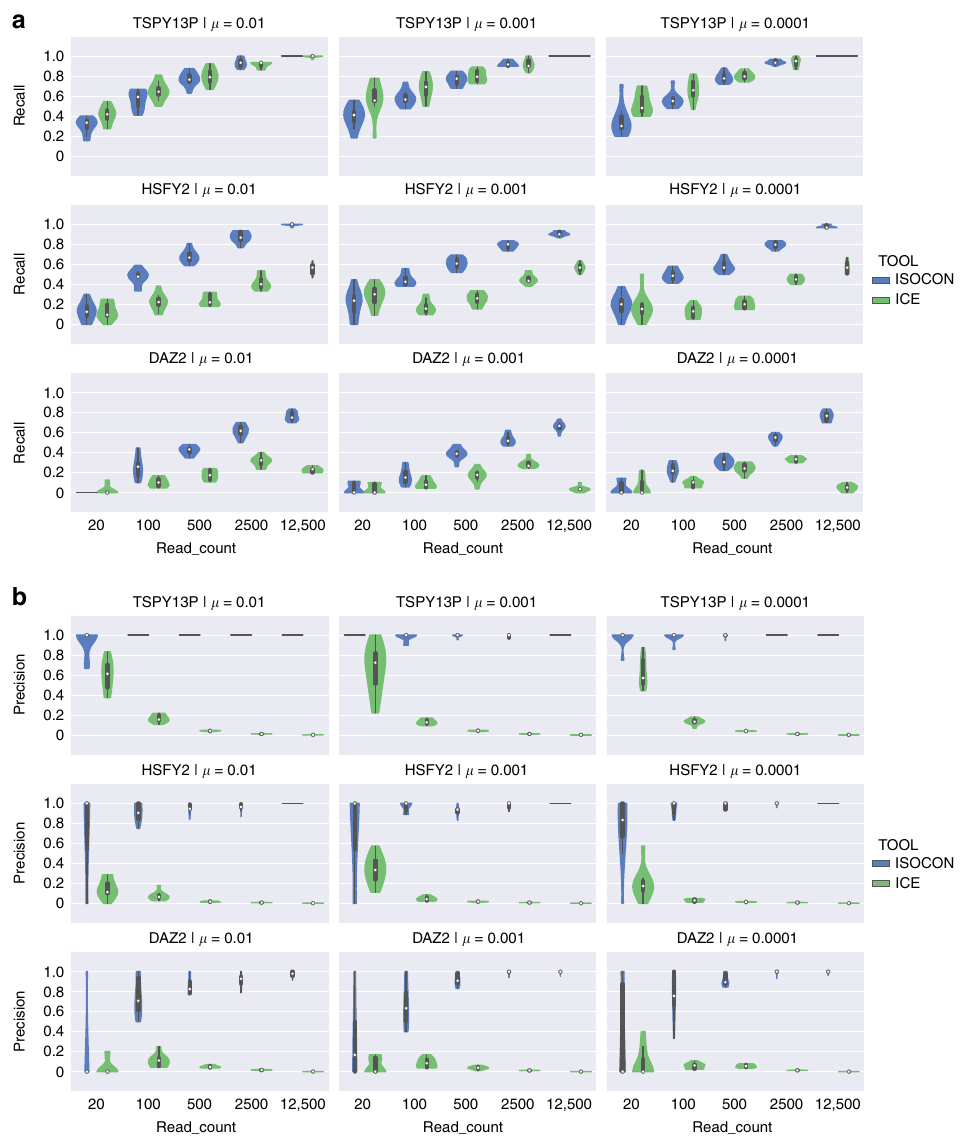
Fig. 1 Recall and precision for transcripts with different exon structure and unequal abundance rates. Violin plots showing the recall ( a ) and precision ( b ) of IsoCon and ICE. In each panel, the rows correspond to different families and, hence, different error rates. The shortest gene family ( TSPY , labeled by the name of the reference gene copy used to generate it, TSPY13P ), with correspondingly lower read error rates, is shown in the top panel rows while the longest gene family ( DAZ , labeled as DAZ2 ), with correspondingly higher read error rates, is shown in the bottom rows. The columns correspond to different mutation rates ( μ ) used in simulating the gene copies (see Supplementary Note 2). A lower mutation rate implies more similar gene copies. Each plot shows results for a total of 30 isoforms with abundances randomly assigned and ranging from 0.1% to 15%. Within each plot, the x -axis corresponds to the number of simulated reads, while the y -axis shows the recall/precision of the methods. Each violin is generated using 10 simulated sequencing replicates. The white dot shows median, the thick black line is the interquartile range (middle 50%), the thinner black line is the 95% con fi dence interval, and the colored area is the density plot. We note that the density plot is cut at the most extreme data